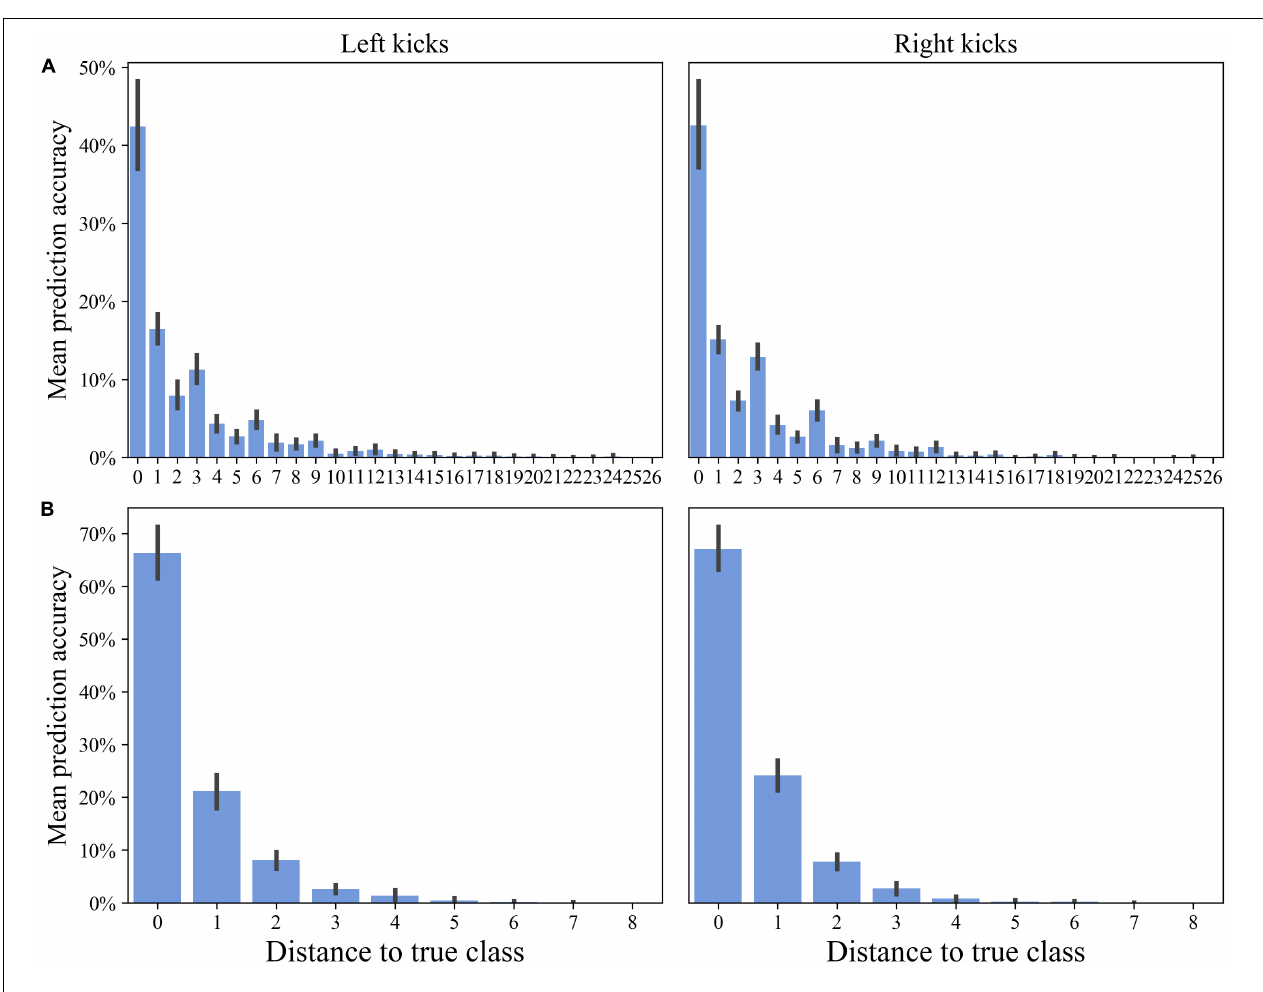
FIGURE 4 | Distances to true classes of the classification of the movement patterns of the left and right kicks depending on the classification task. Presented here are the means and SDs for each distance. A distance of zero to the true class refers to the prediction accuracy of the true class (e.g., a distance of two means that the predicted class is two classes next to the true class). (A) Block classification. Consider that distances of 14 and higher will not occur in all cases (e.g., block 14 has only 13 blocks before and 13 after). (B) Set classification. Consider that distances of five and higher will not occur in all